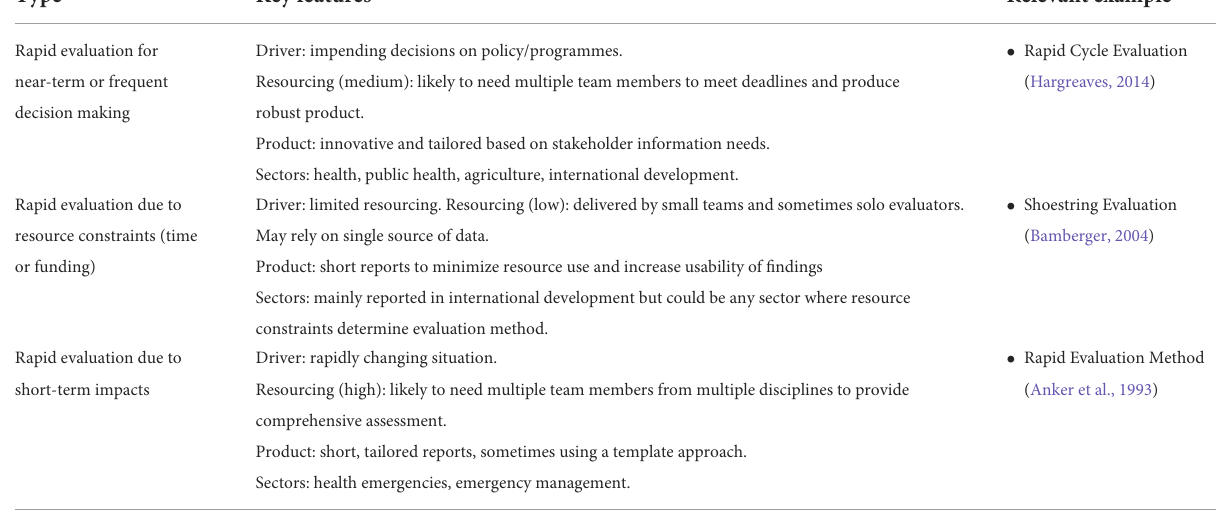
TABLE 3 Types, features, and drivers of rapid